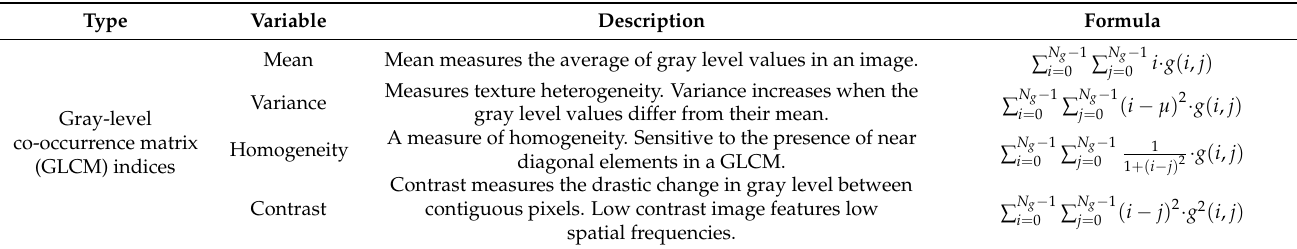
Table A1. Description of the selected texture parameters of Gray-Level Co-Occurrence Matrix (GLCM). Type Variable Description Formula